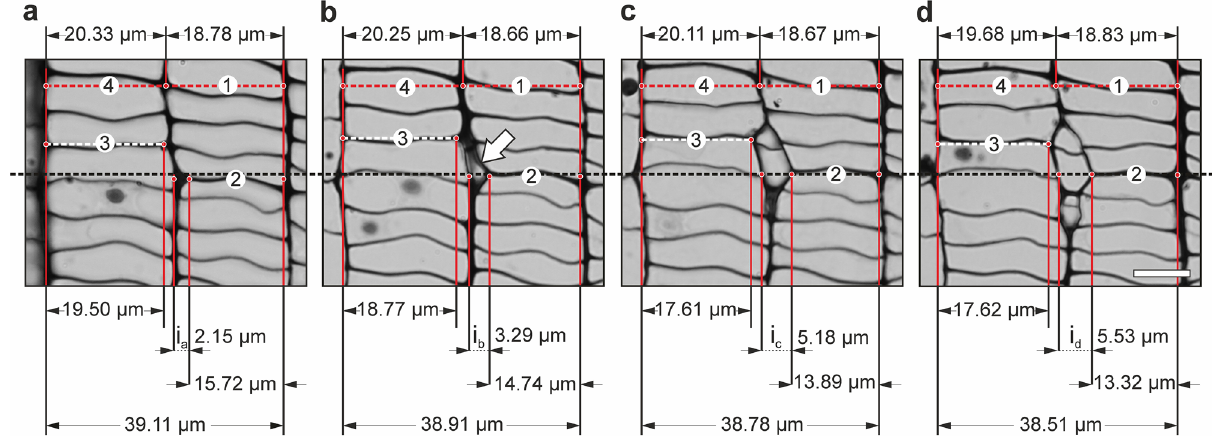
Figure 4. Transverse sections showing intrusively growing initial cell of the vascular cambium of Robinia pseudoacacia L. The four consecutive sections ( a , b , c , d ) are spaced from each other by ca. 3.5 μm (in axial direction). Tangential dimensions of considered elements were marked. Black, dashed line corresponds to approximate location of the initial surface. Red, dashed line goes through cambial derivative cells deposited onto the phloem side. Analysed tangential cell walls were numbered 1, 2, 3, and 4. Their length was measured without considering the curvature. i indicates example of a slant created in the vascular cambium as a result of intrusive growth of an initial cell. Scale bar = 10 μm. Adobe Photoshop CS6 Extended ver.13.0 × 64 (https:// www. adobe. com), and CorelDRAW